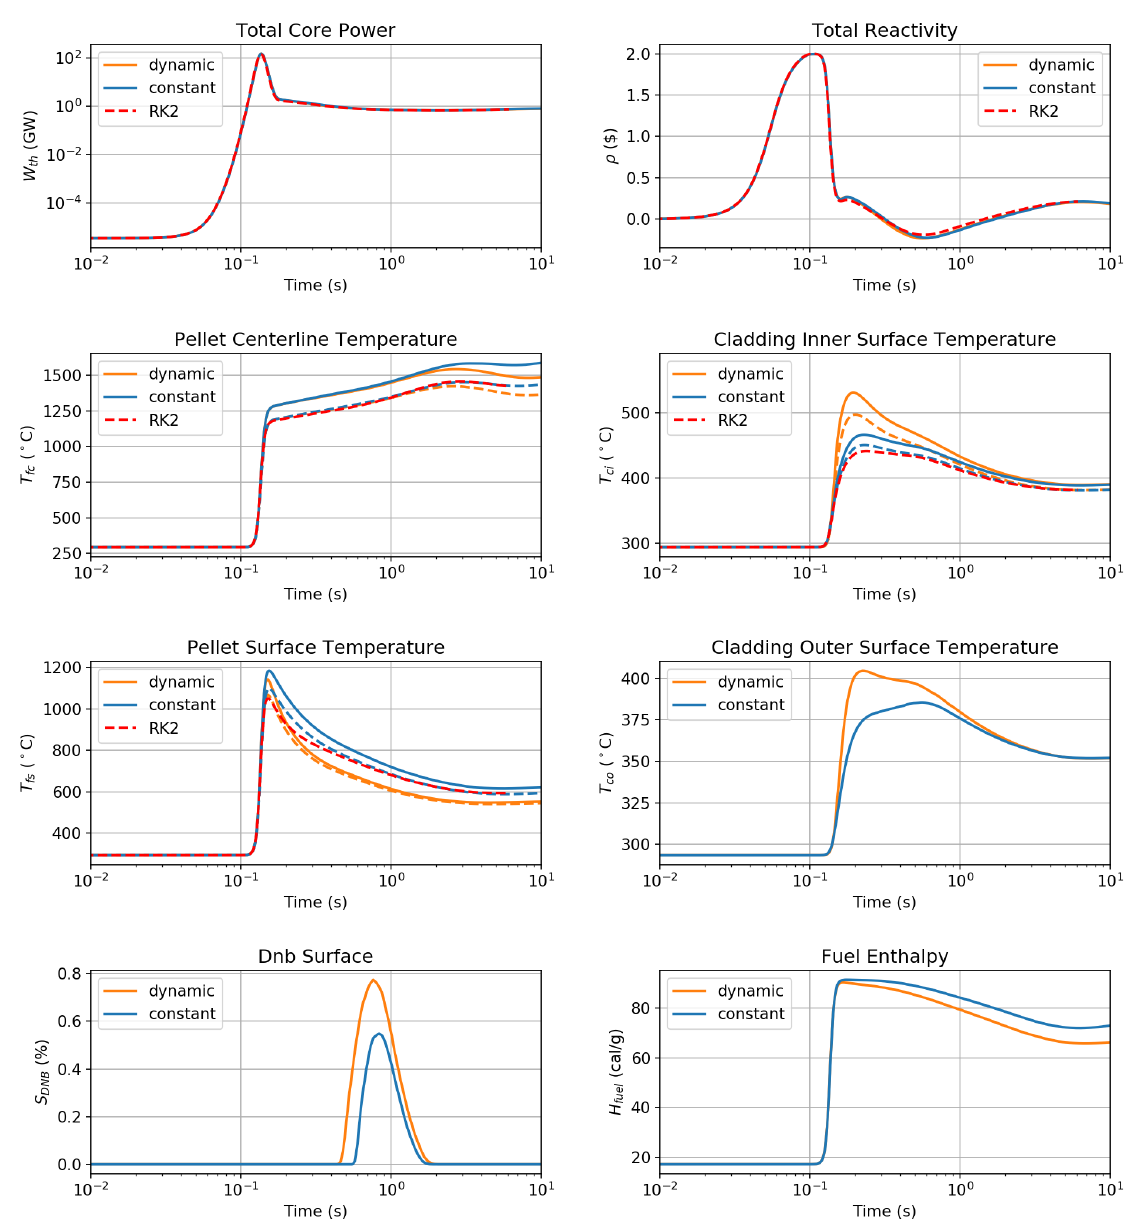
Figure 4. Peaking values of the safety parameters as a function of time calculated by MPCORE using dynamic and static gap HTC models, and by RAST-K v.2 with a built-in thermal-hydraulics solver. The solid lines refer to the pin-wise distribution, the dashed lines refer to the assembly-wise